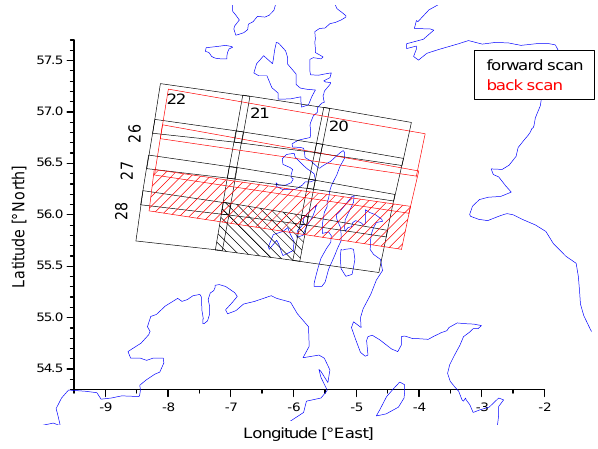
Fig. 2. Forward (black) and back scans (red) of the GOME-2 instru- ment north of Ireland (16 May 2010 10:09 UTC). For both scanning modes one pixel is hatched to emphasise the size of the individual pixels and to illustrate the overlapping areas. The numbers in the forward pixels indicate the pixel number, while the swath number is written to the